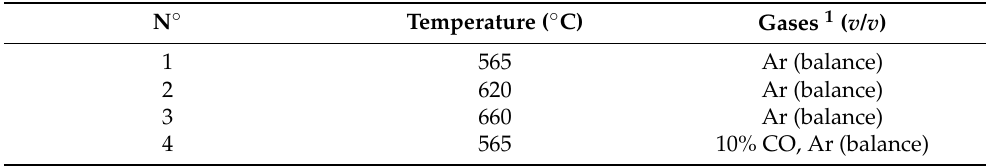
Table 2. Experiments carried out with benzene: naphthalene flowrate ratio of 2.45:1 (catalyst: 1 g, space velocity 940–960 mL/min g